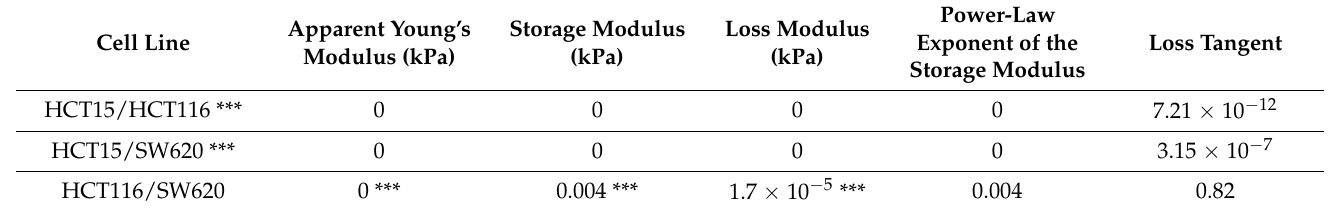
Table 2. Statistical data treatment of HCT15, HCT116, and SW620. The Wilcoxon Rank’s test was used. ( *** ) Statistically significant differences between the distinct CRC cell lines ( p <